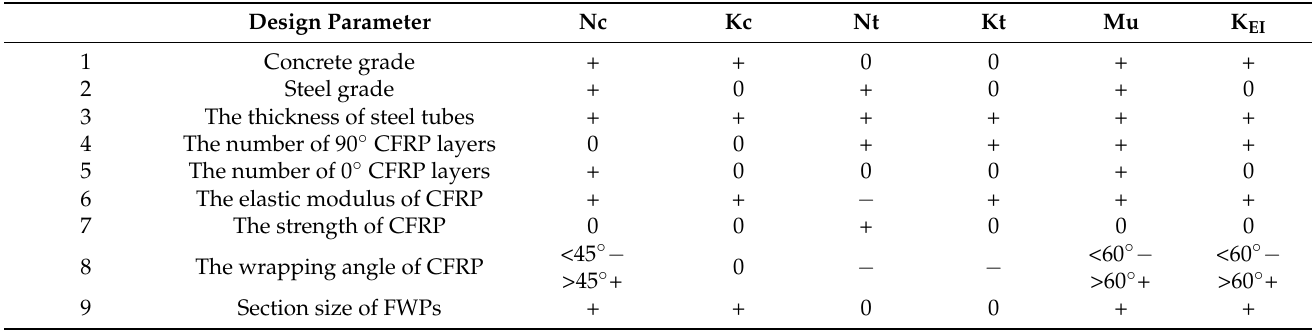
Table 10. Summary of effects of design